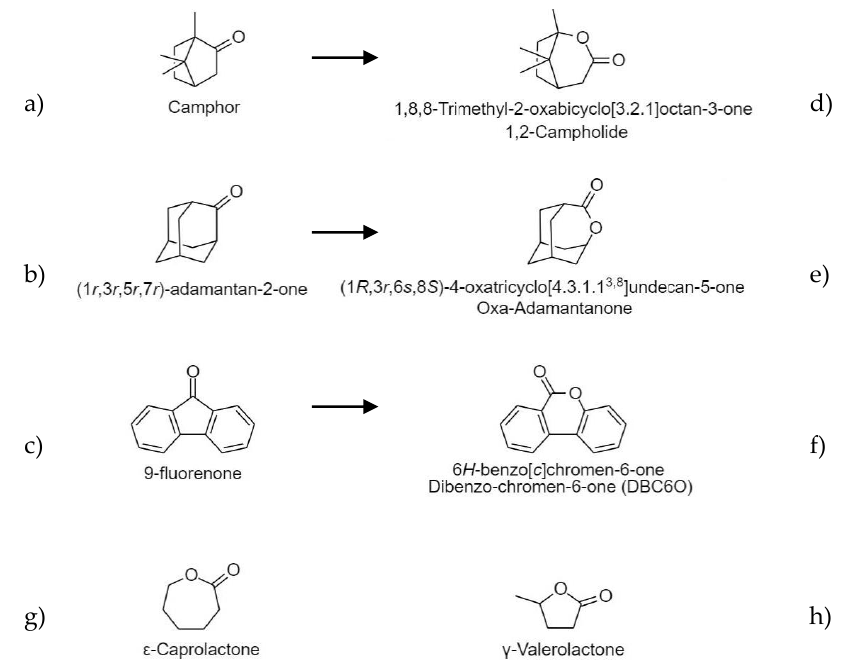
Figure A1. Structures, IUPAC and given names of precursor cyclic ketones ( a , b , c ), the relative lactones produced ( d , e , f ) and the commercial lactones studied ( g , h ).